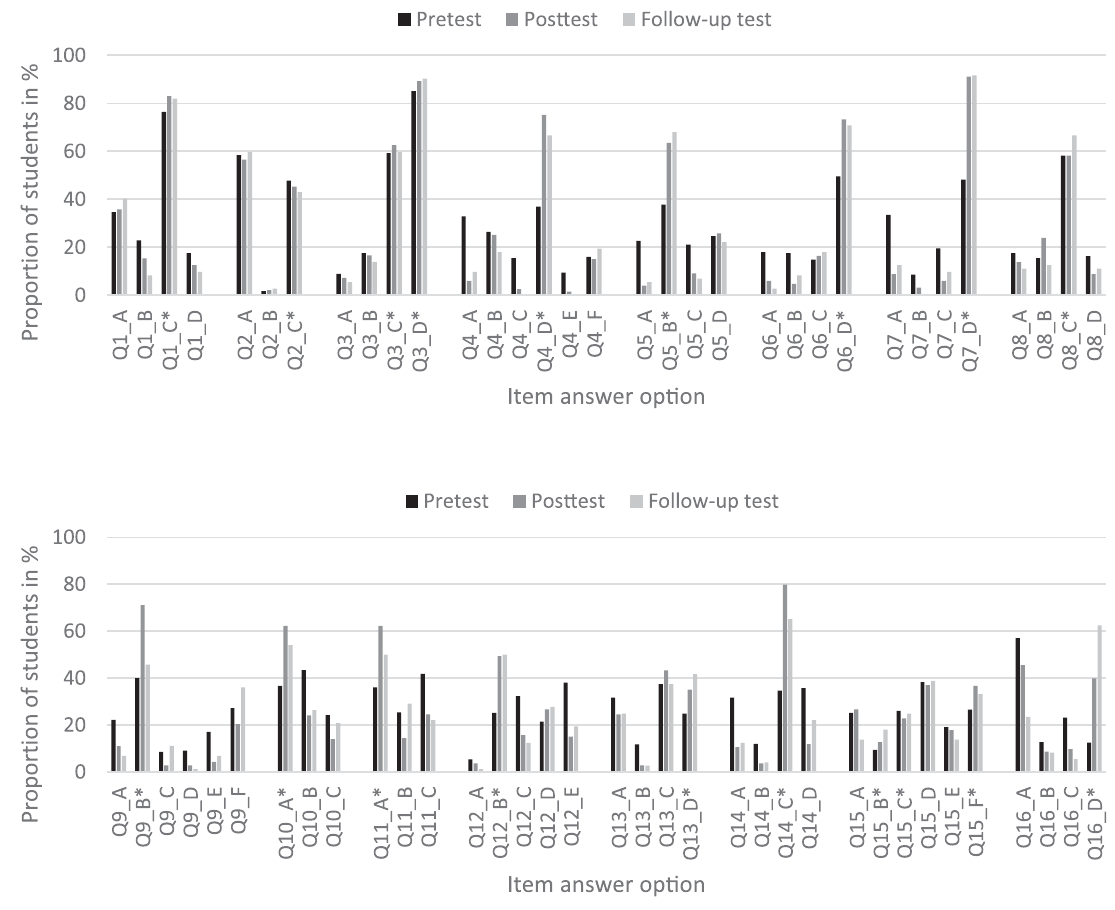
FIG. 4. Percentage of the students who selected each answer option for all 16 items in the pre-, post-, and follow-up test (split up in Q1 – Q8 and Q9 – Q16). Correct answer options are indicated by an